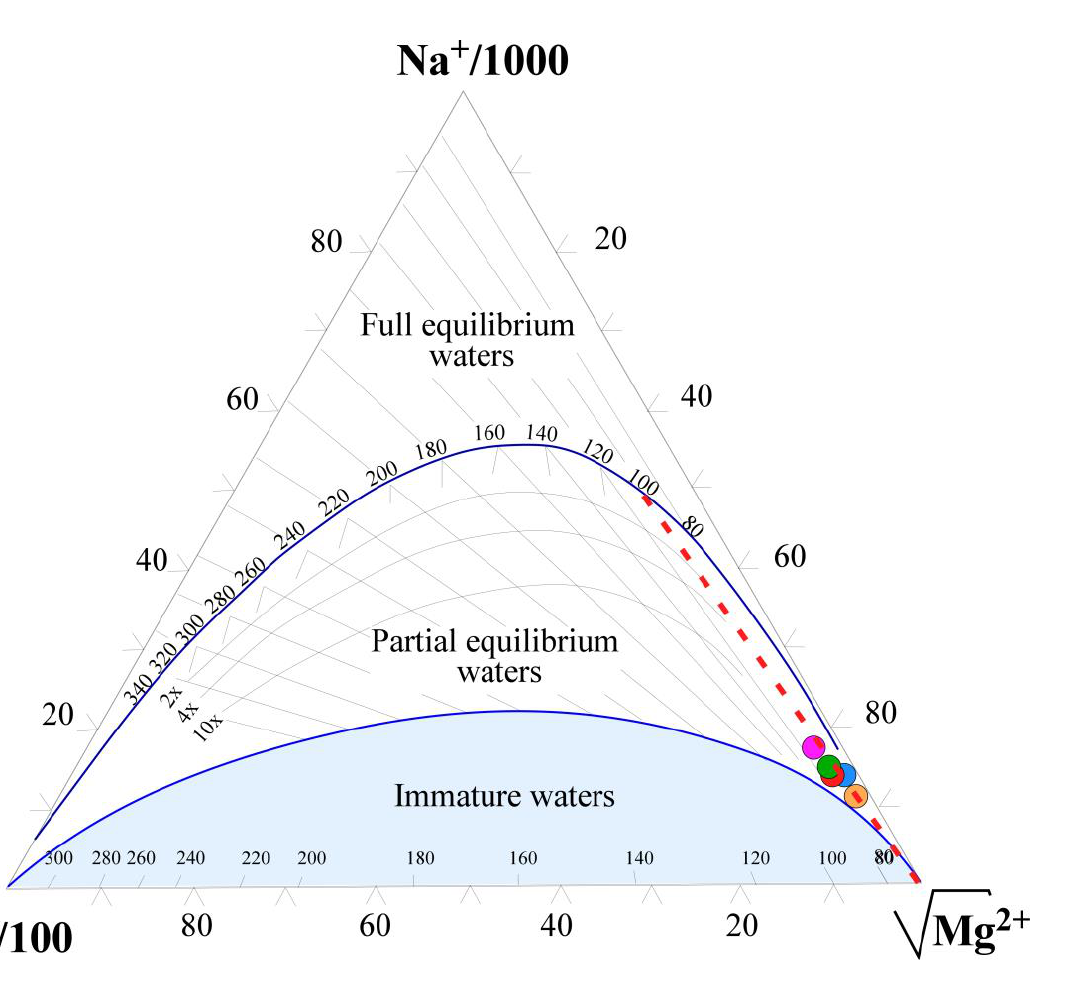
Table 3. Deep reservoir temperatures estimated by aqueous geothermometers (°C) .